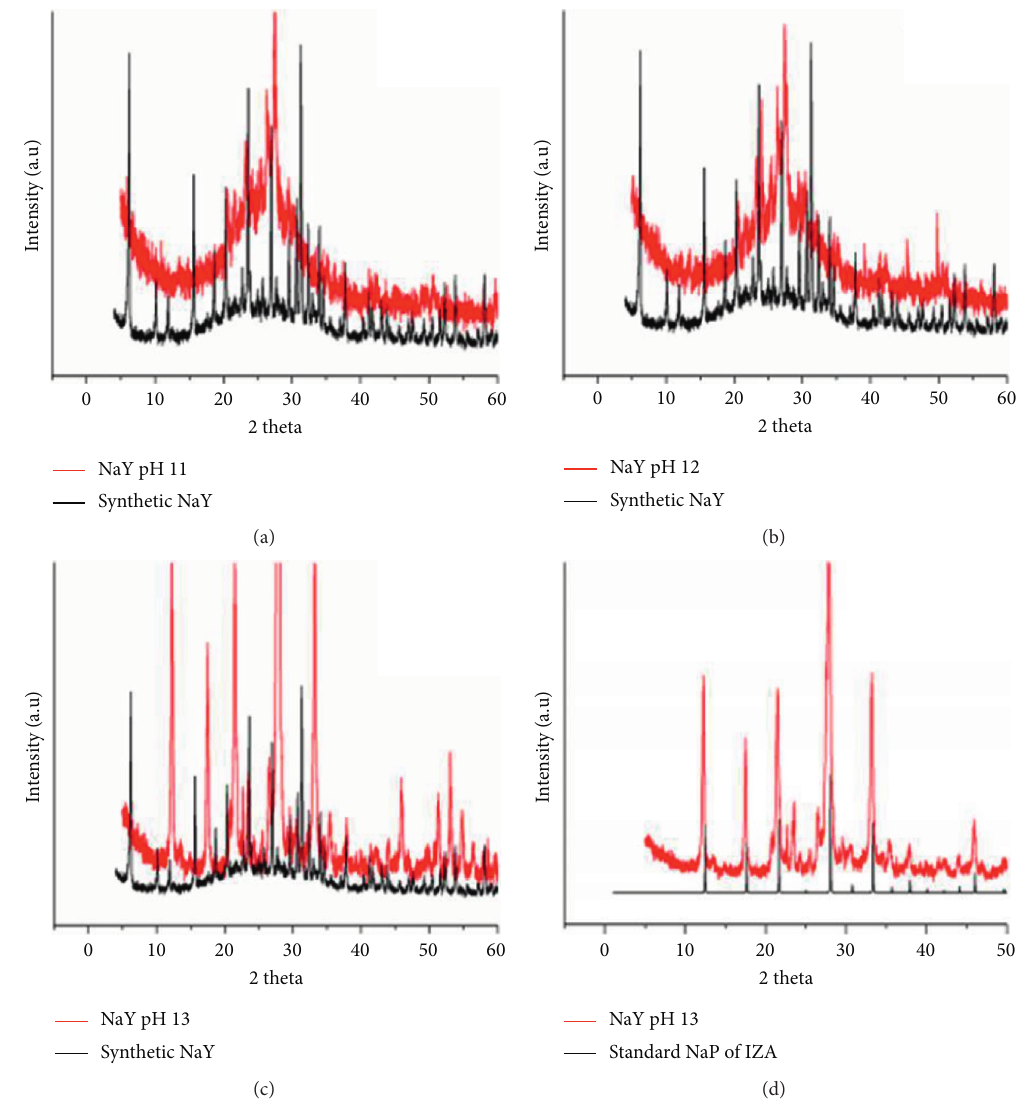
Figure 3: Comparison of NaY zeolite XRD pattern at (a) pH 11, (b) pH 12, (c) pH 13, and (d) pH 13 with that of standard NaP zeolite adopted from [16].